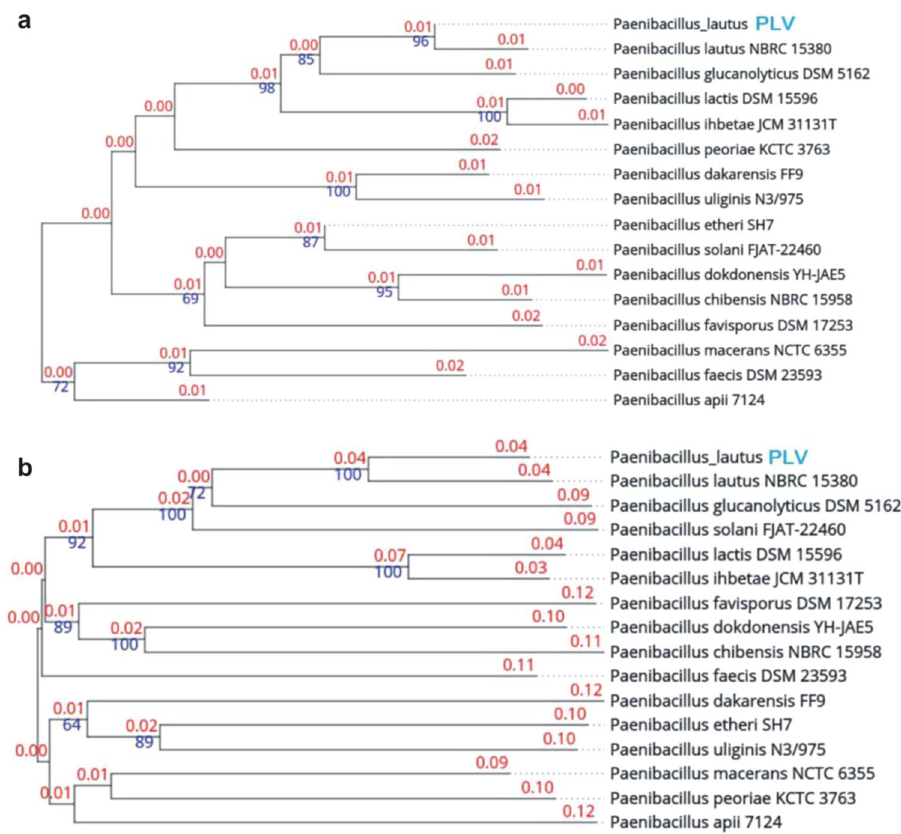
Figure 1. ( a ) SSU tree. Tree inferred with FastME 2.1.6.1 29 from GBDP distances calculated from 16S rDNA gene sequences. The branch lengths are scaled in terms of GBDP distance formula d5. The numbers above branches are GBDP pseudo-bootstrap support values > 60% from 100 replications, with an average branch support of 76.9%. The tree was rooted at the midpoint 30 . ( b ) Genome tree—Tree inferred with FastME 2.1.6.1 29 from GBDP distances calculated from genome sequences. The branch lengths are scaled in terms of GBDP distance formula d5. The numbers above branches are GBDP pseudo-bootstrap support values > 60% from 100 replications, with an average branch support of 75%. The tree was rooted at the midpoint 29 .